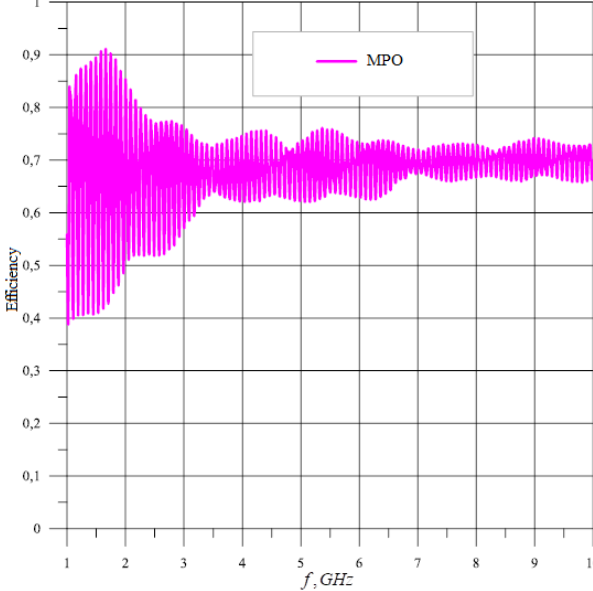
FIGURE 7. Estimated surface utilization factor in the frequency range from 1 to 10 GHz .